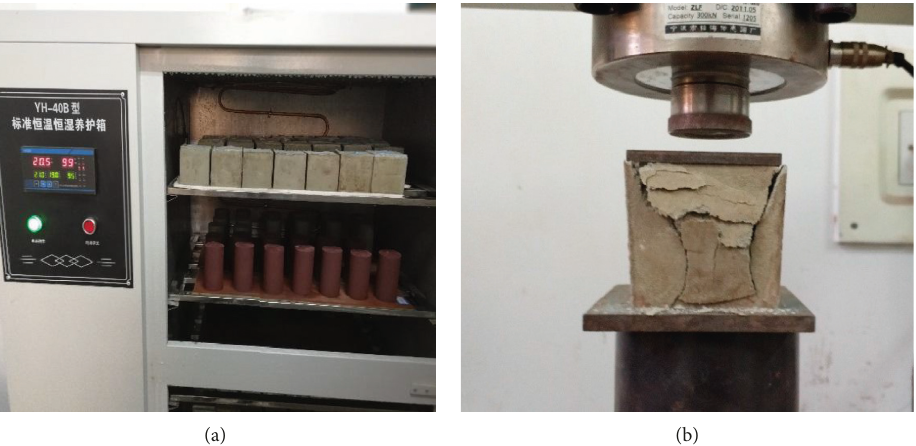
Figure 1: Uniaxial compressive strength test process. (a) The CTB samples; (b) the TYE-300D and the destroyed CTB sample.